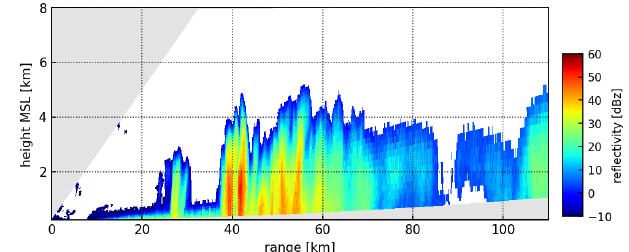
Figure 12. RHI scan on 11 February 2020 at 07:30UTC towards 86 ◦ . Note that the shallow layer with low reflectivity is sea